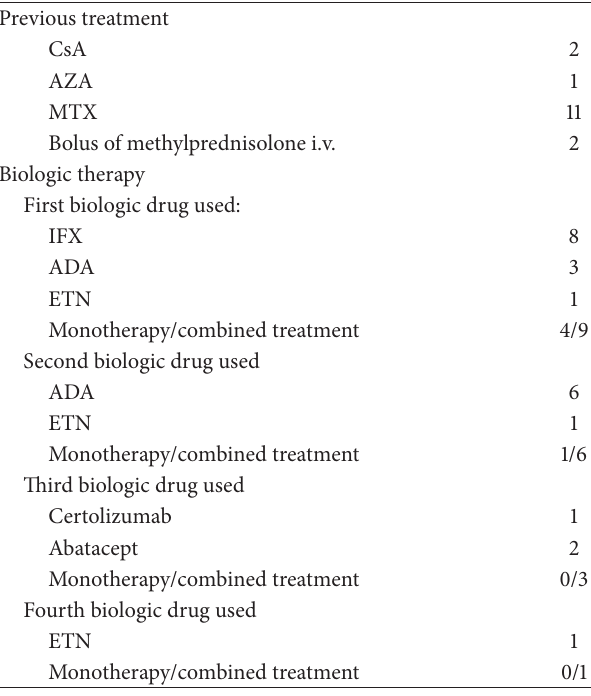
Table 2: Previous immunosuppressive therapies in all included